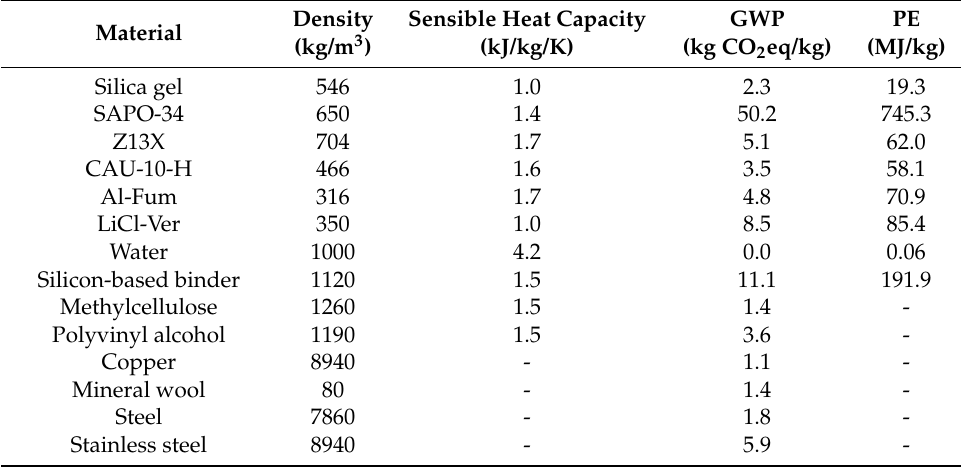
Table A1. Overview on material properties and life cycle impact values used for